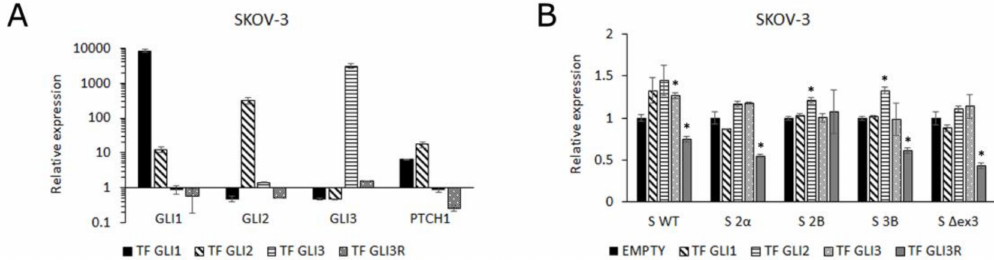
Figure 4. The effect of GLI1, GLI2, GLI3, and GLI3R overexpression in the SKOV-3 WT cell line on ( A ) the expression levels of GLI1 , GLI2 , GLI3 , and PTCH1 and ( B ) the expression levels of survivin isoforms. * represents statistically significant changes in expression compared with cells transfected with empty